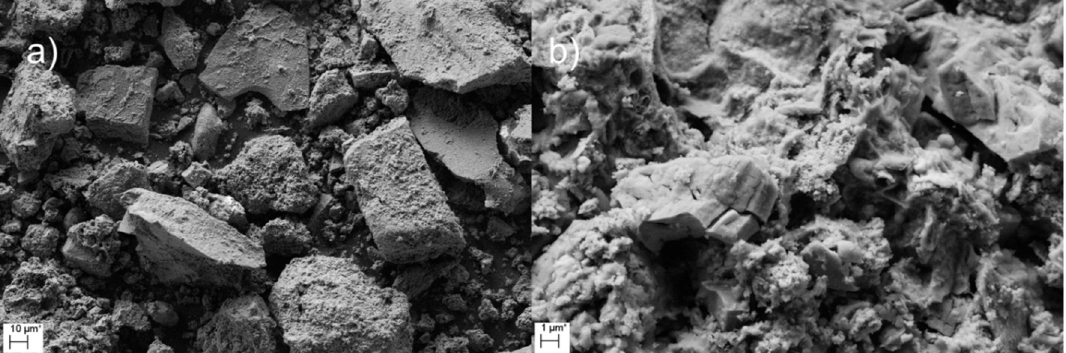
Figure 10 . XRD diffractogram of the precipitate from the precipitation of agricultural sludge (Mg:P:N = 1.3:1:1) using dolomite 750 °C (Mg:P:N = 1.3:1:1): 1 = CaCO 3 ; 2 = (NH 4 MgPO 4 · 6H 2 O).